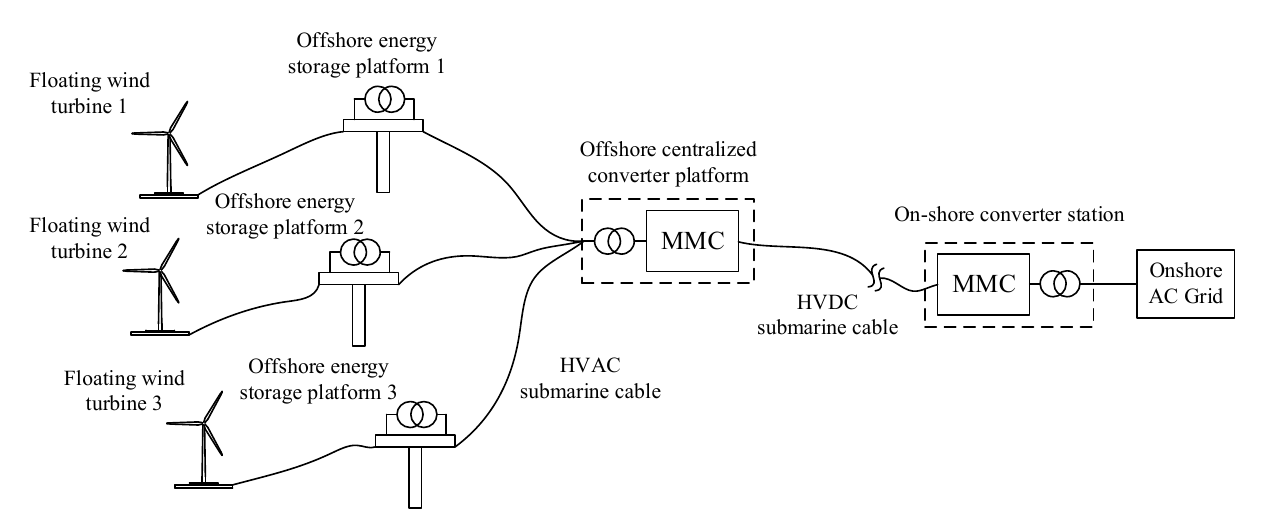
Figure 5. The basic architecture of an offshore floating storage-integrated wind farm.